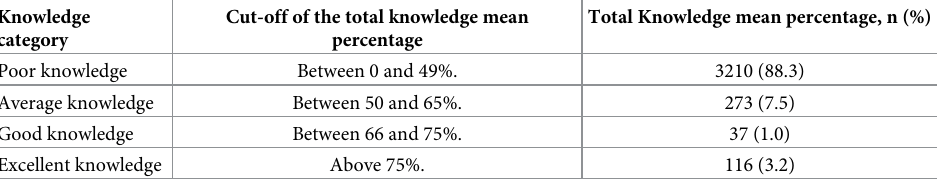
Table 2. The cut-off of the knowledge mean percentage and the distribution of the study participant among the knowledge